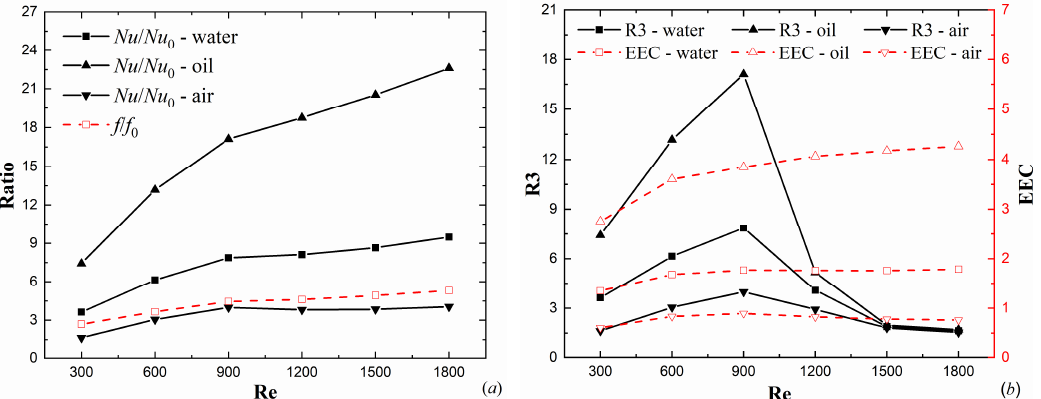
Figure 12. Thermal hydraulic performance with different working fluid: ( a ) The enhanced ratios Nu / Nu 0 and f / f 0 ; ( b ) The evaluation criteria R3 and